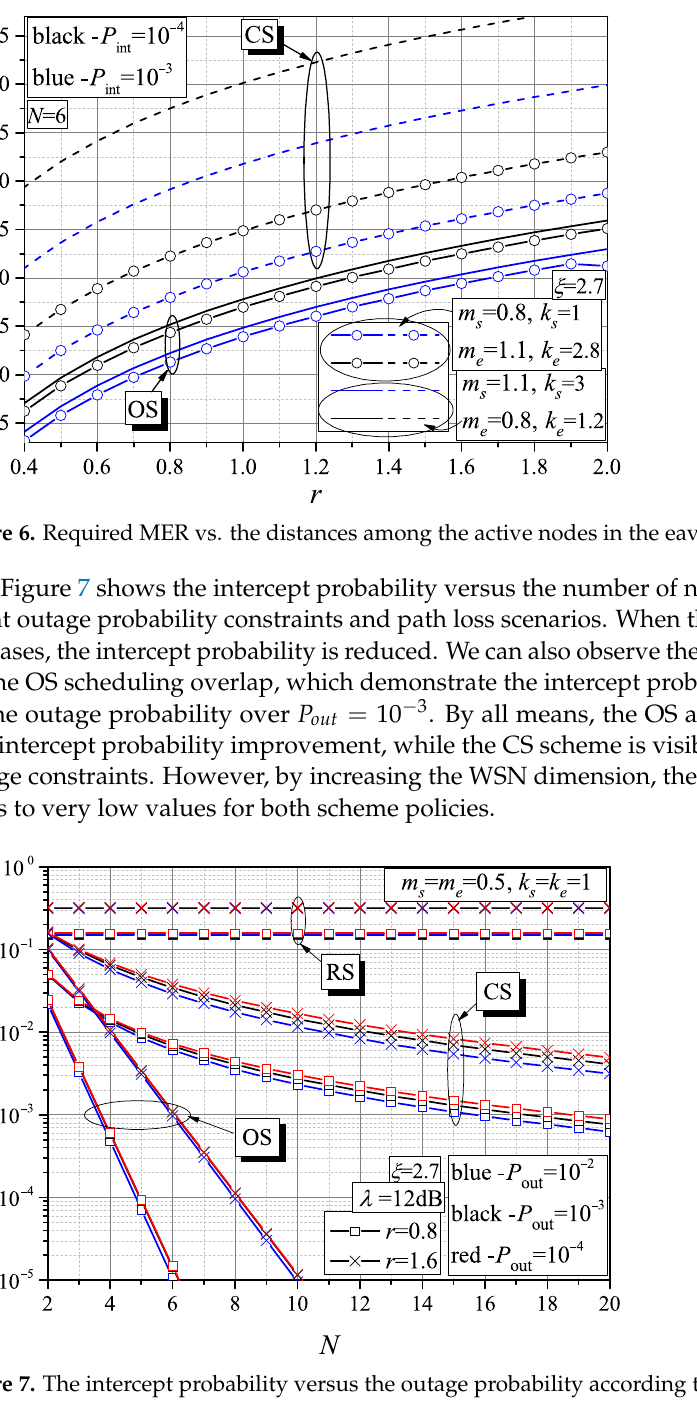
the nodes and the node characteristics, until the required PLS is